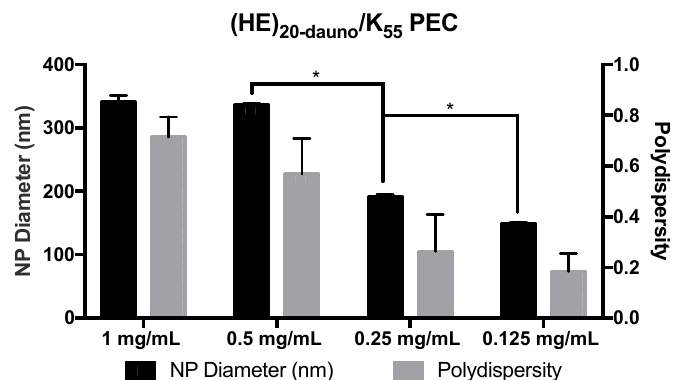
Figure 6. PEC formulated from (HE) 20-dauno and K 55 demonstrated significant concentration dependence in size at concentrations below 1 mg/mL. Polydispersity of the PEC decreased along with the size, and was statistically significant at concentrations below 1 mg/mL. Data shown are averages of four wells ± standard deviation. Results were analyzed by two-way ANOVA with p < 0.05 indicated (*).